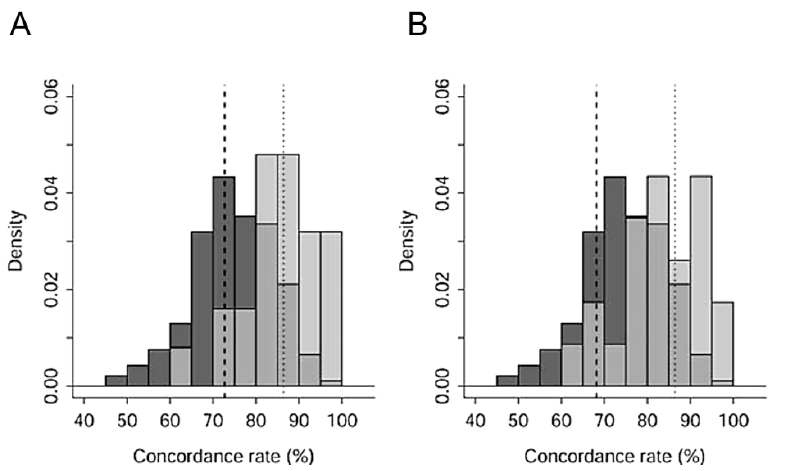
Figure 2. Histograms of concordance rates in pairs of red-crowned cranes in Hokkaido. A: parent– offspring pairs (pale grey) and non-relative pairs (dark grey). B: Full-sibling pairs (pale grey) and non-relative pairs (dark grey). Intermediate grey shows the redundant part of blood relatives and non-relatives in A and B. Dotted lines in A and B: upper 5% point non-relative pairs. Dashed line in A: lower 5% point of parent–offspring pairs. Dashed line in B: lower 5% point of full-sibling pairs. Parent–sibling pairs, 25; full sibling pairs, 21; non-relative pairs, 366.